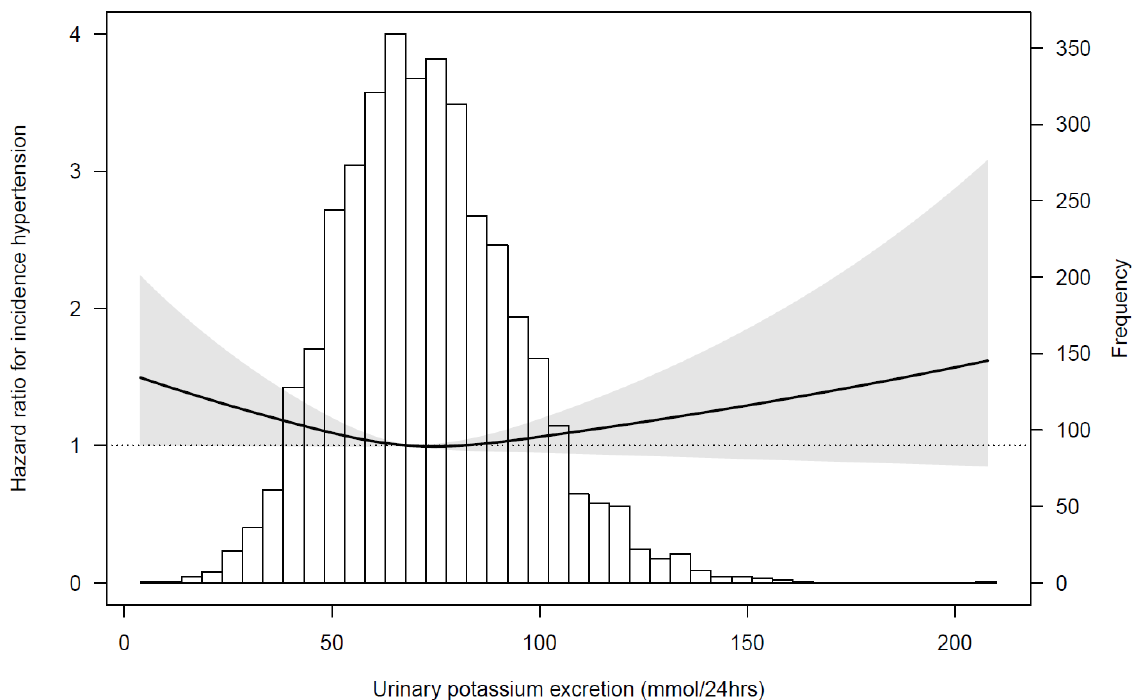
Figure 1. Associations between urinary potassium excretion and incident hypertension in 3720 participants. Data were fit by a Cox proportional hazards regression model adjusted for age, BMI, eGFR, urinary sodium excretion, urinary albumin-to-creatinine ratio, smoking status, alcohol consumption, diabetes, history of cardiovascular disease, anti-diabetic, and lipid lowering drugs. The grey area represents the 95% CI. Abbreviations: eGFR, estimated glomerular filtration rate; BMI, body mass index.